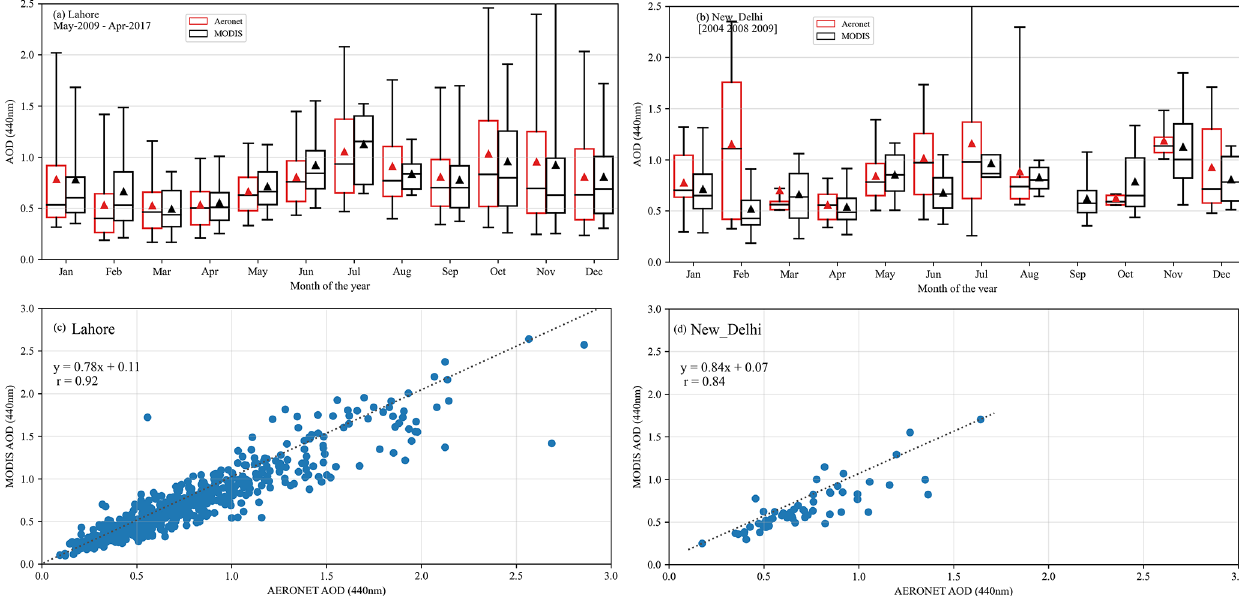
Figure F5. Monthly variation in the AOD (at 440nm) as observed by AERONET sun photometers (red boxes) and MODIS (black boxes) at two sites ( a , Lahore and, b , New Delhi), which are the nearest stations to Mohali in the Indo-Gangetic Plain. Panels (c) and (d) show the corresponding scatter plots indicating the agreement in the daily MODIS and AERONET measurements.